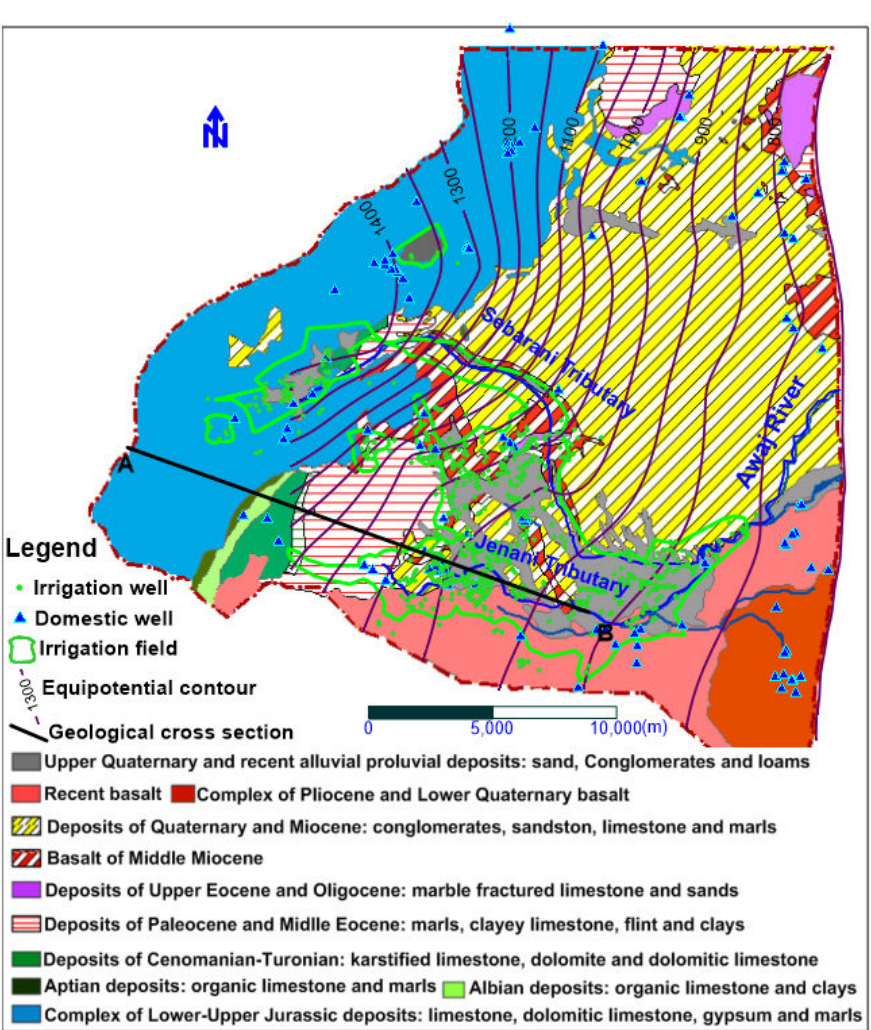
Figure 3. The different geological formation outcrop in the study area, after [30,31], equipotential contours map of October 2006 and location sites of irrigation field and spatial distribution of abstraction